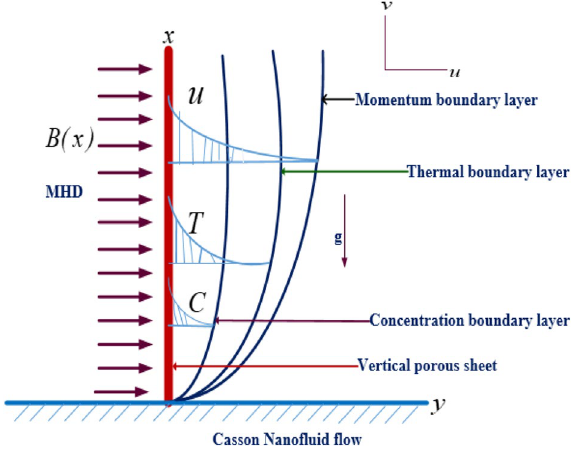
Figure 1. Geometric flowing